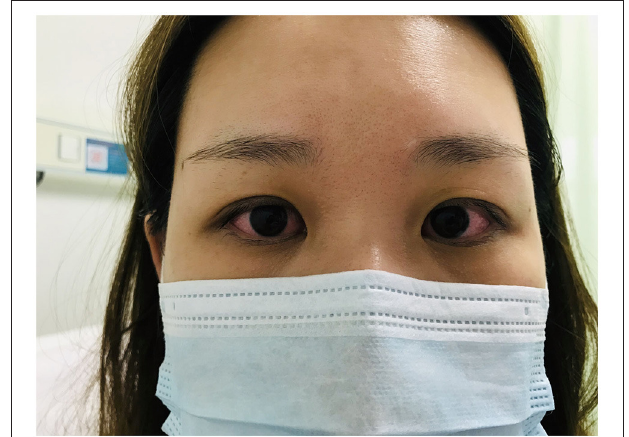
FIGURE 1 | Signs of binocular conjunctival congestion in a female patient who underwent LC. This patient presented with binocular conjunctival congestion but without secretions, tearing, itching, pain, burning/stinging, photophobia, foreign body sensation, eye discomfort, or decreased vision within 6